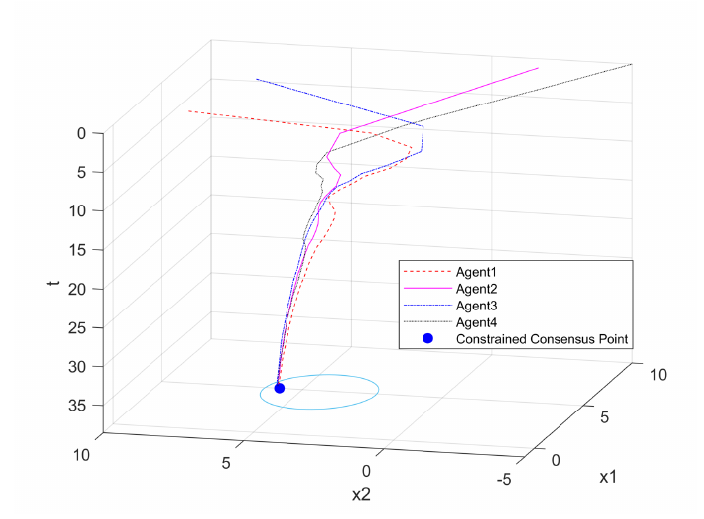
Figure 6. All state trajectories of agents in our method.